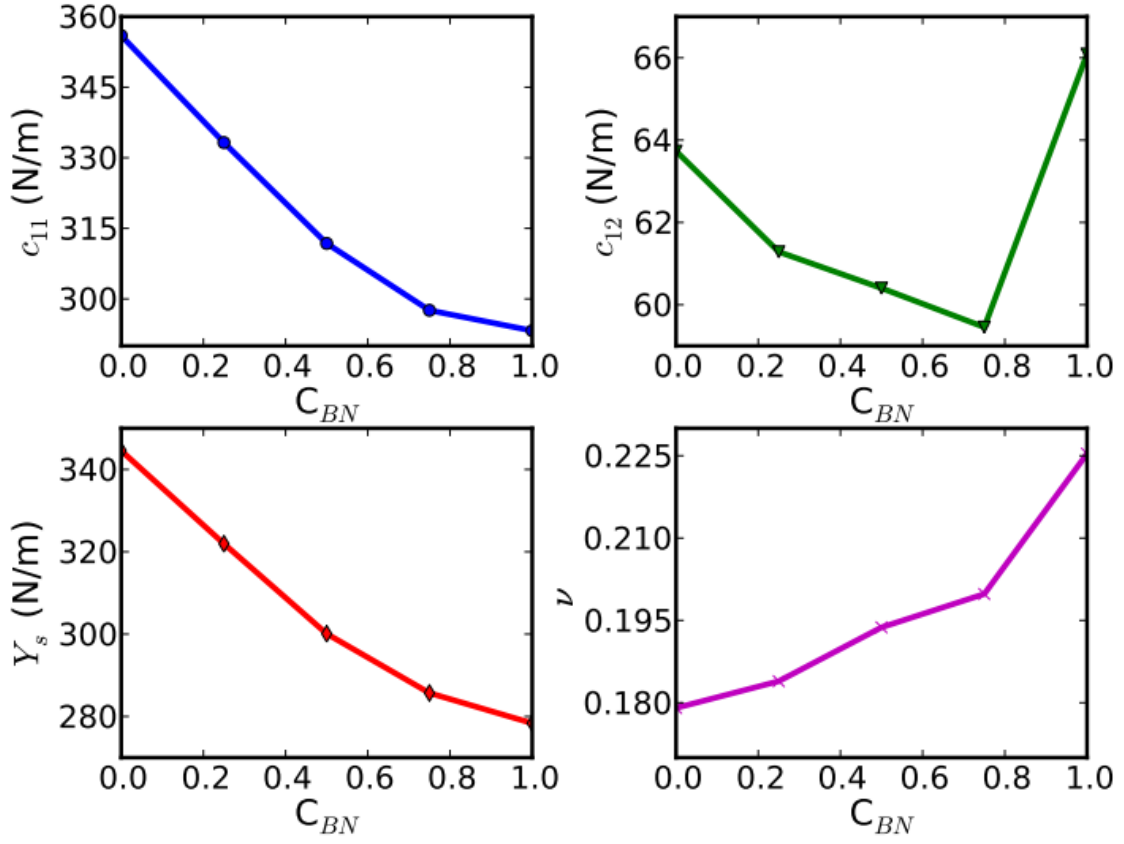
Figure 6. Linear elastic constants (SOEC) c 11 , c 12 , Y s , and n as a function of g -BN concentrations C BN . Due to the symmetry, only C 11 and C 12 are independent. C 11 decreases linearly with respect to C BN , as plotted in the top panel of Figure 6. Our results of Y s , ν from Equations (19) and (20) and elastic constants of the five configurations are shown in bottom panels of Figure 6. Our calculated value of in-plane stiffness of graphene (344.6 N/m) is in good agreement with the experimental value (340 ± 50 N/m) [12] and theoretical predictions (348 N/m [18] and 335 N/m [67]). Our calculated value of g-BN (278.3 N/m) agrees with an ab initio (GGA-PW91) prediction (267 N/m in ref. [67]). Poisson’s ratios ν are 0.18 and 0.23 for graphene and g-BN, in agreement with 0.16 and 0.21, respectively [67]. Our results of Y s , ν , C 11 , and C 12 are also comparable with ab initio predictions [68] and tight-binding calculations [69] of BN nanotubes.